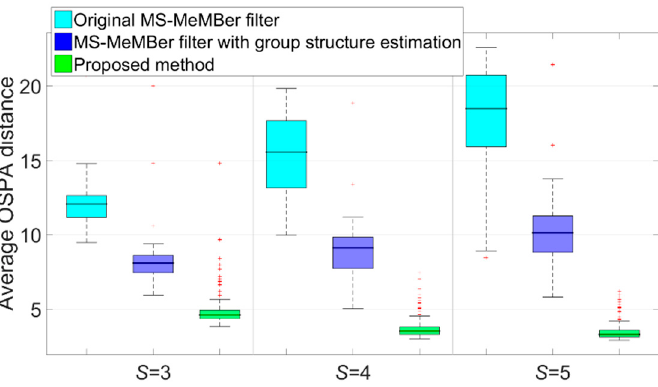
Figure 11. Box plot of time-average OSPA distance errors with different sensor numbers (50 MC runs).